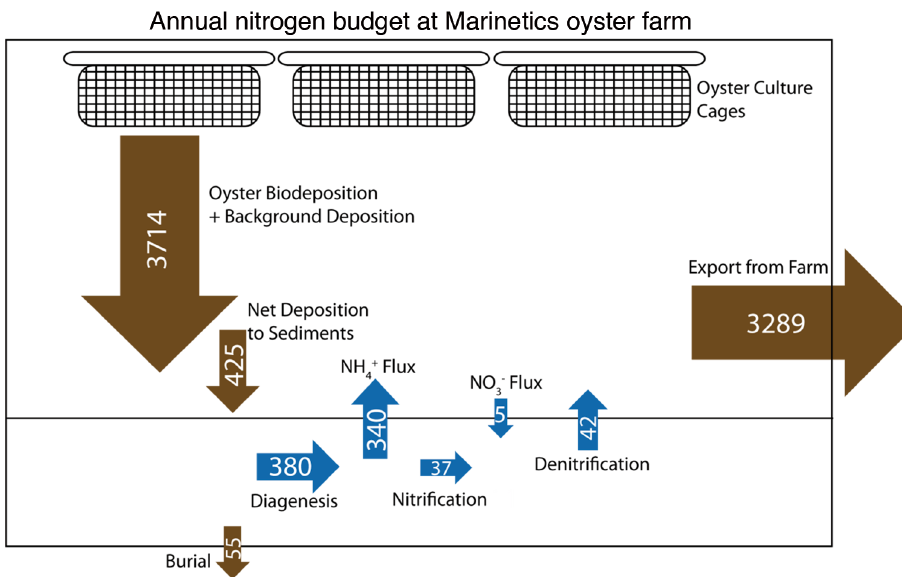
Fig 11. Annual nitrogen budget for the Marinetics oyster farm. Brown arrows represent physical transport, while blue arrows represent biogeochemical fluxes. Clearly, the majority of the material that could potentially be integrated into the sediments is exported from the site before biogeochemical transformation could occur. NH 4+ fluxes dominate the sediment–water exchanges. All units in µmol m –2 h